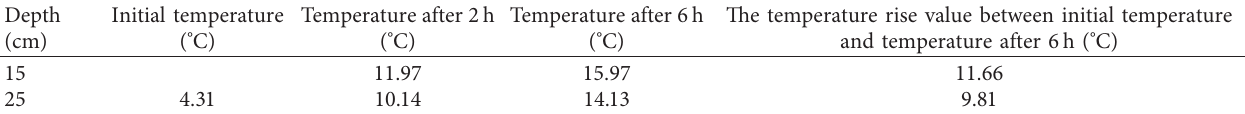
Table 7: Temperature rise value of the first layer under two buried depths.